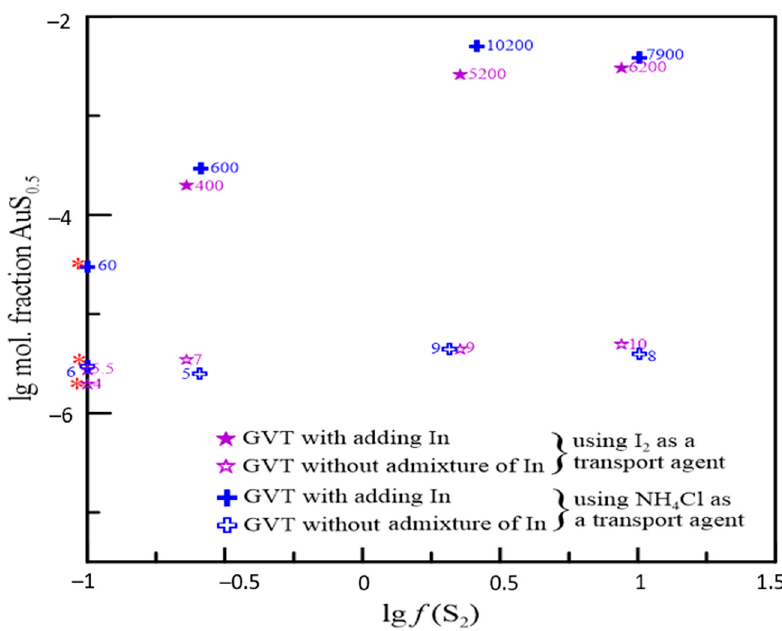
Figure 36. Graph showing the relation between the In and Au concentrations in the synthetic crystals of sphalerite. Numbers near the marks correspond to C Au , ppm. GVT (gas vapour transport)—gas transport method. Synthesis procedure is described in [90].